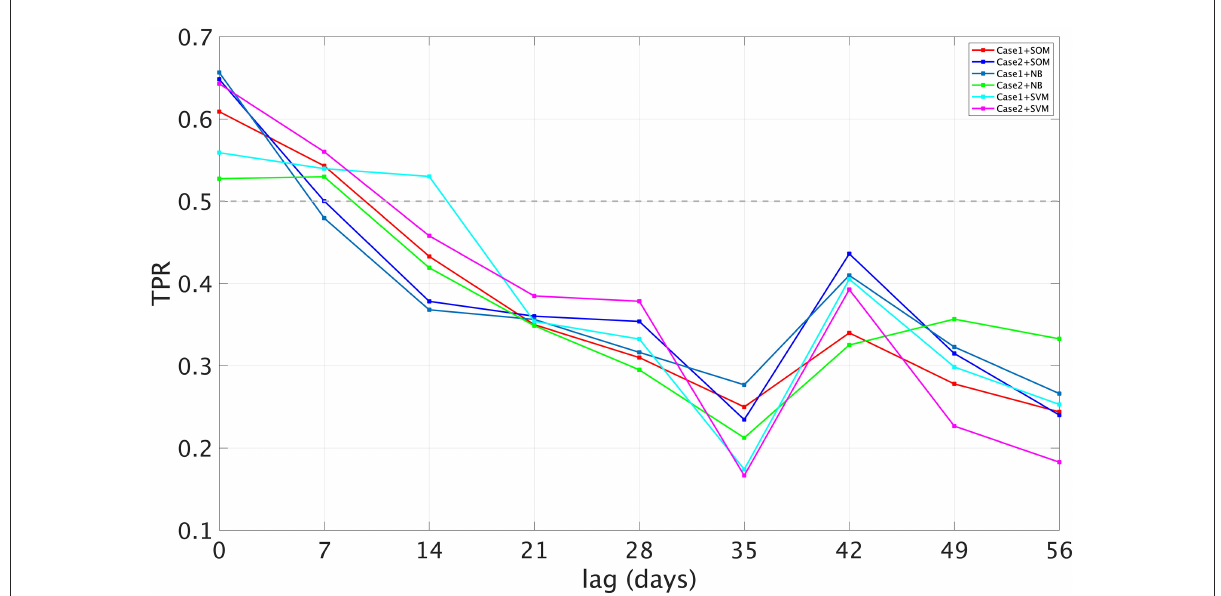
FIGURE10 Spatially averaged TPR with different combinations of cases and cluster algorithms. The 50% threshold is indicated by the dashed grey line at 0.5.